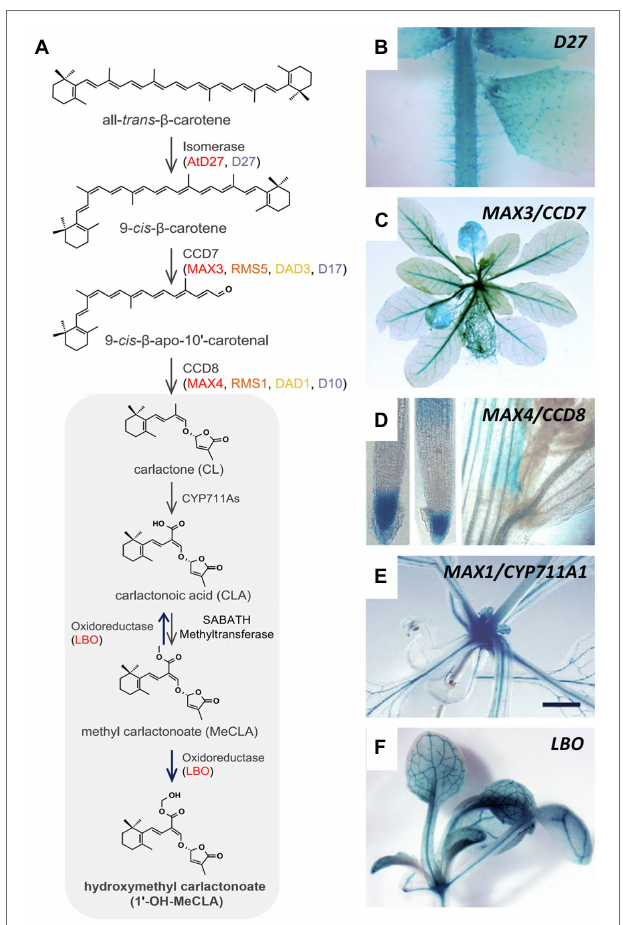
FIGURE 3 | Expression pattern of SL-biosynthetic genes in Arabidopsis. (A) Biosynthetic pathway of strigolactone comprising the activity of the isomerase D27, the carotenoid cleavage dioxygenases CCD7 and CCD8, CYP711A, the oxidoreductase LBO, and the SABATH methyltransferase. (B–F) Expression pattern of Arabidopsis SL-biosynthetic genes such as D27 (B) , CCD7 / MAX3 (C) , CCD8 / MAX4 (D) , CYP711A1 / MAX1 (E) , and LBO (F) , as indicated, revealed by promoter::GUS analysis. Note prominent expression in the vasculature of MAX3 , MAX1 , and LBO [ C,E,F ; modified with permission from Yoneyama and Brewer, 2021 (A) ; Abuauf et al., 2018 (B) ; Liang et al., 2011 (C) ; Sorefan et al., 2003 (D) ; Booker et al., 2005 (E) , and Brewer et al., 2016 (F)